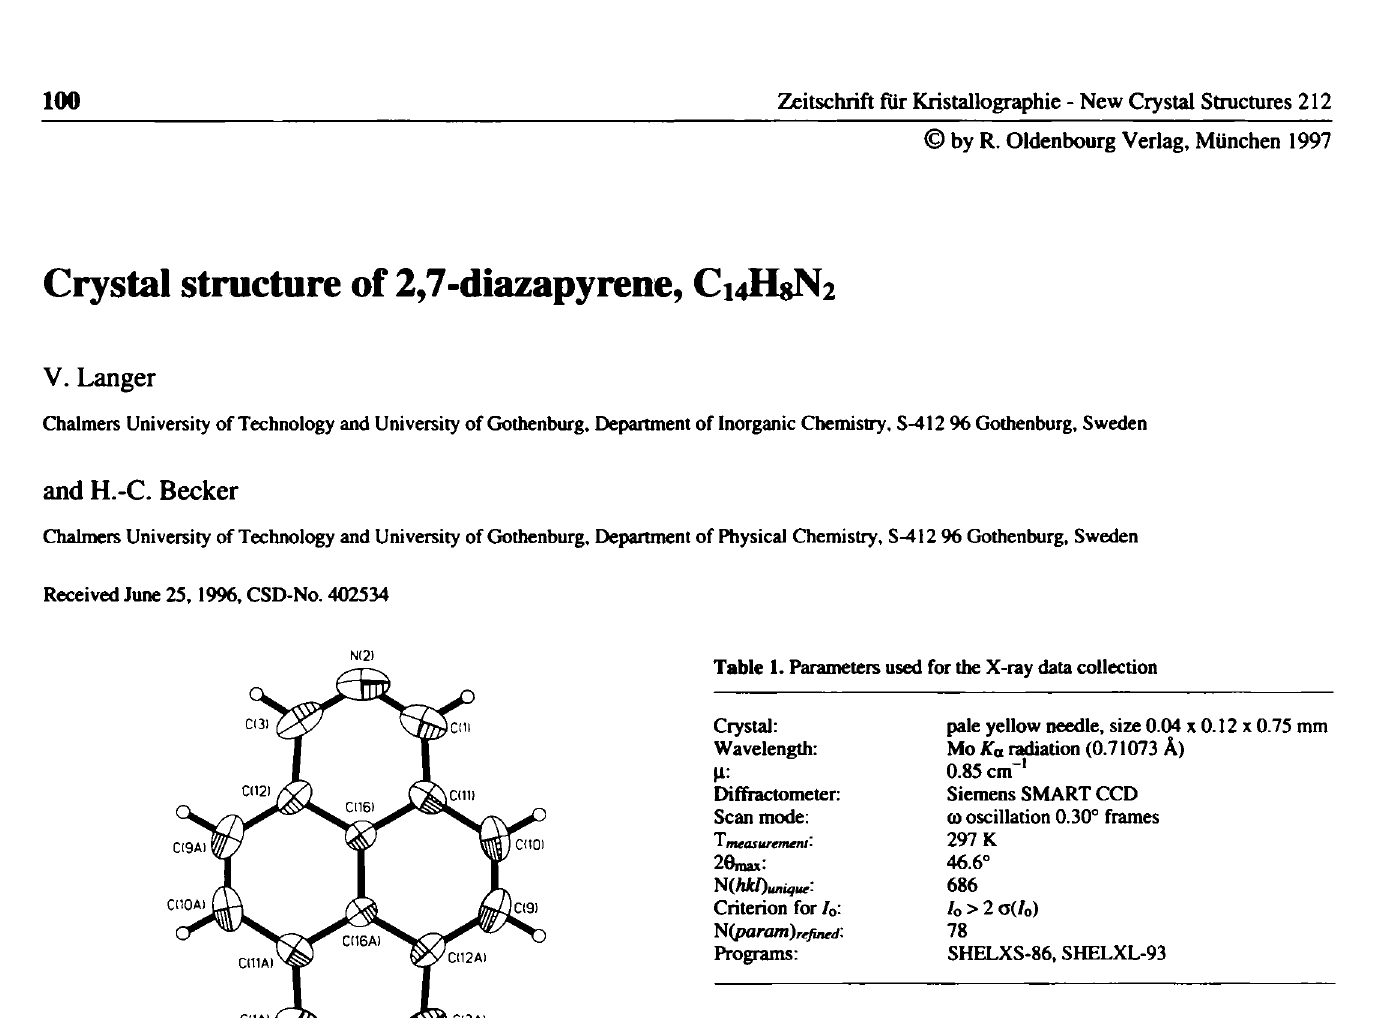
Table 2. Final atomic coordinates and displacement parameters (in Â 2